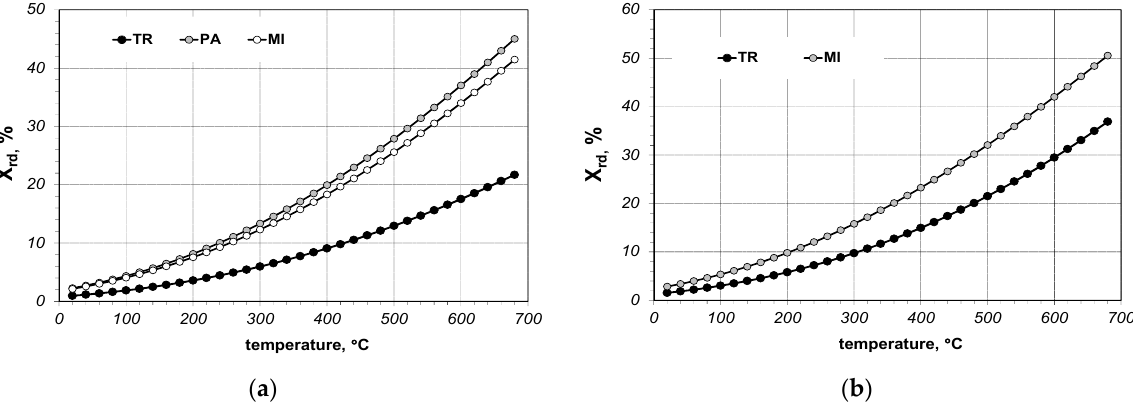
Figure 7. Calculation results of the radiation conductance depending on the contact coefficient and surface emissivity.